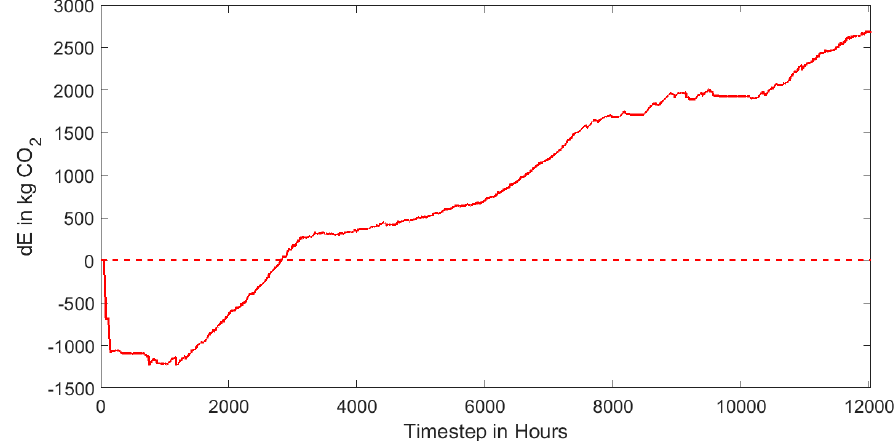
Figure 17. Difference of cumulated CO 2 emissions to the reference simulation with standard controller for scenario #3.